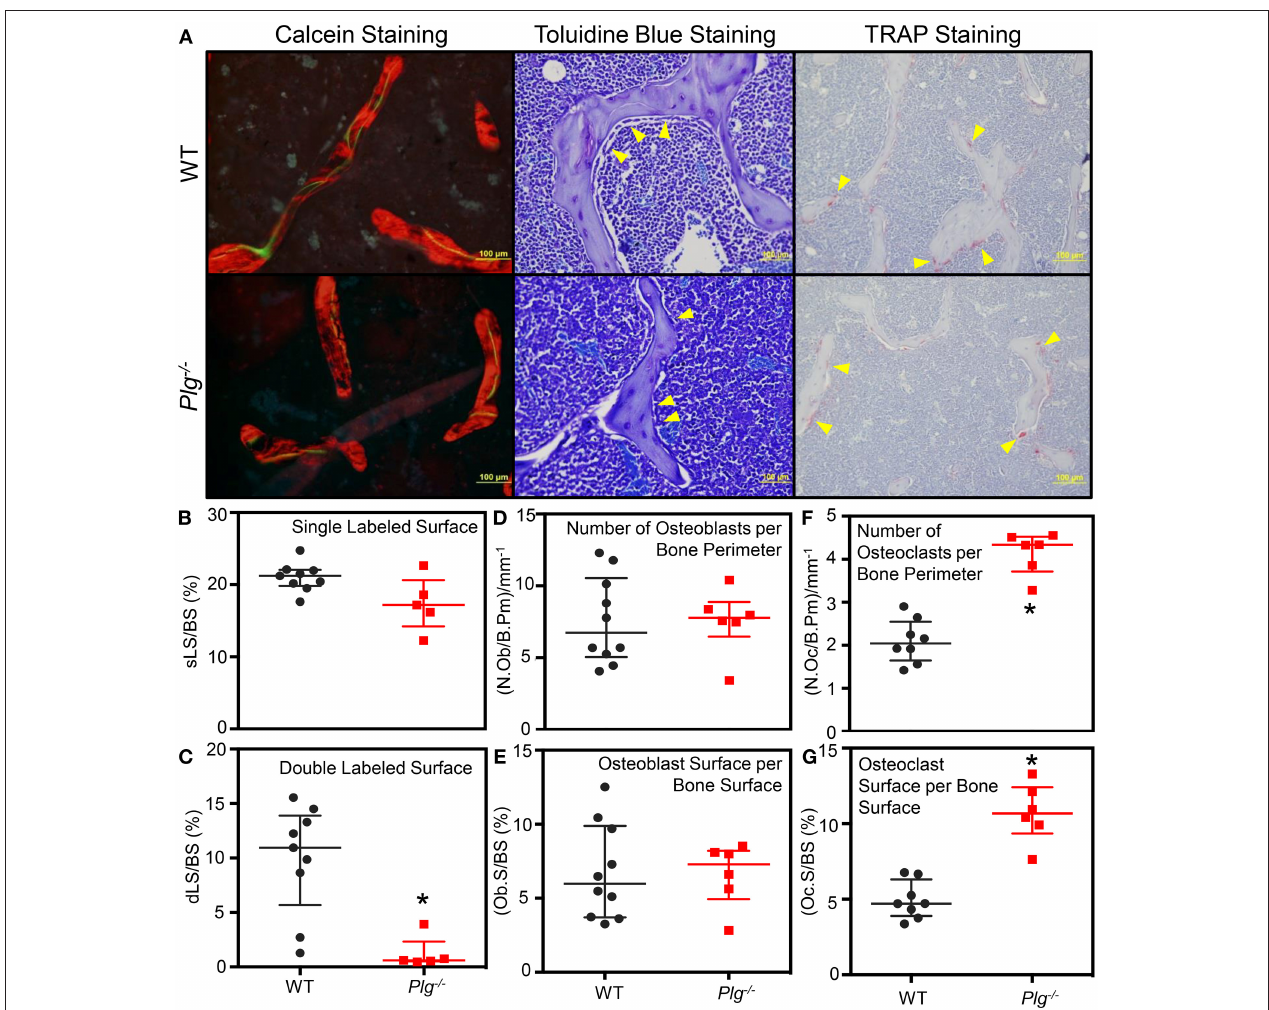
FIGURE 5 | Impaired fibrinolysis, as a result of a plasminogen deficiency, leads to impaired bone remodeling and bone volume. (A) Representative images from the histological analysis of the secondary spongiosa from the distal femur of Plg − / − and WT control mice at 10 weeks of age by calcein (20 × ), Toluidine blue (40 × ), and TRAP staining (20 × ). Plg − / − N = 3, WT control N = 4 (Calcein Staining) and WT N = 5 (Toluidine blue and TRAP staining), two sections analyzed per mouse. (B–G) Bone histomorphometic analysis of the secondary spongiosa of the distal femur of Plg − / − and WT control mice at 10 weeks of age. The percent of single labeled surface per bone surface (sLS/BS) (B) and the percent of double labeled surface per bone surface (dLS/BS) (C) were analyzed following calcein injections at 10 and 3 days prior to sacrifice. The number of osteoblasts per bone parimeter (N.Ob/B.Pm) (D) and the percentage of osteoblast surface per bone surface (Ob.S/BS) (E)